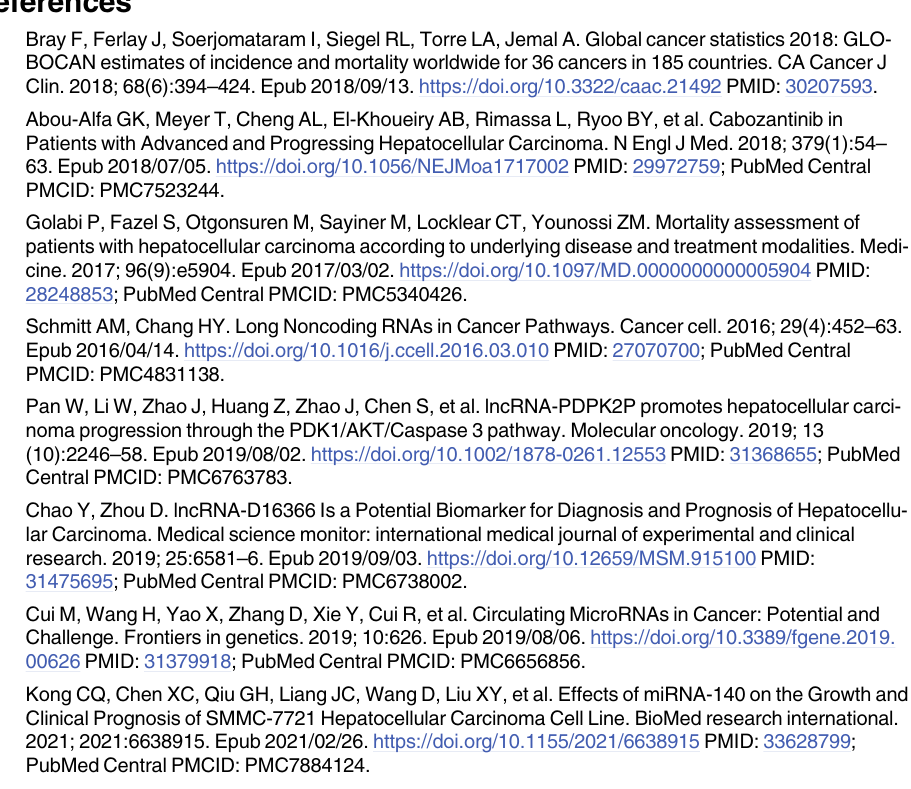
S2 Fig. PAPOLG expression on protein level was verified in Human Protein Atlas (HPA) database. (TIF) S3 Fig. Identification of miRNAs with low expression and good prognosis in HCC. (TIF) S4 Fig. Identification of lncRNAs with high expression and poor prognosis in HCC.